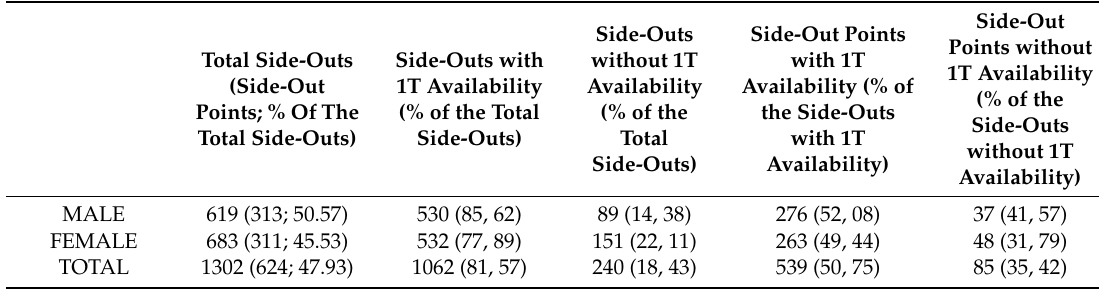
Table 3. Frequencies of the side-out and first tempo availability.